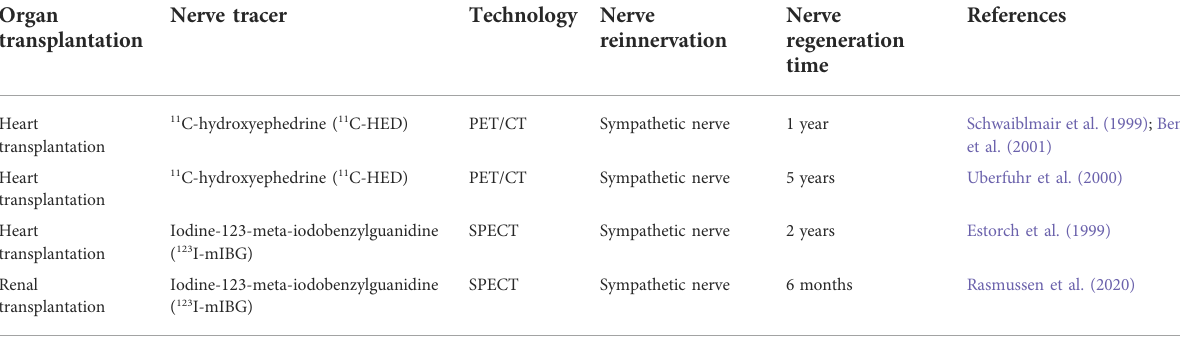
TABLE 2 The use of clinically available radiotracers in heart and renal transplantation.